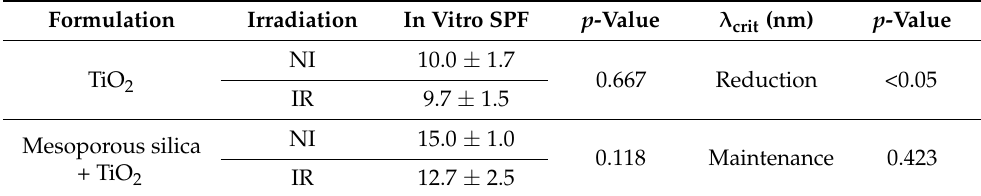
Figure 2. Photostability test. Absorption curves in the UV range, generated by the UV-2000 software, of the lipstick base, SBA-15, TiO 2 (free form) and SBA-15 + TiO 2 samples, before and after irradiation (IR) in the Suntest CPS+. Table 4. Functional photostability of the formulations (before and after UV irradiation).